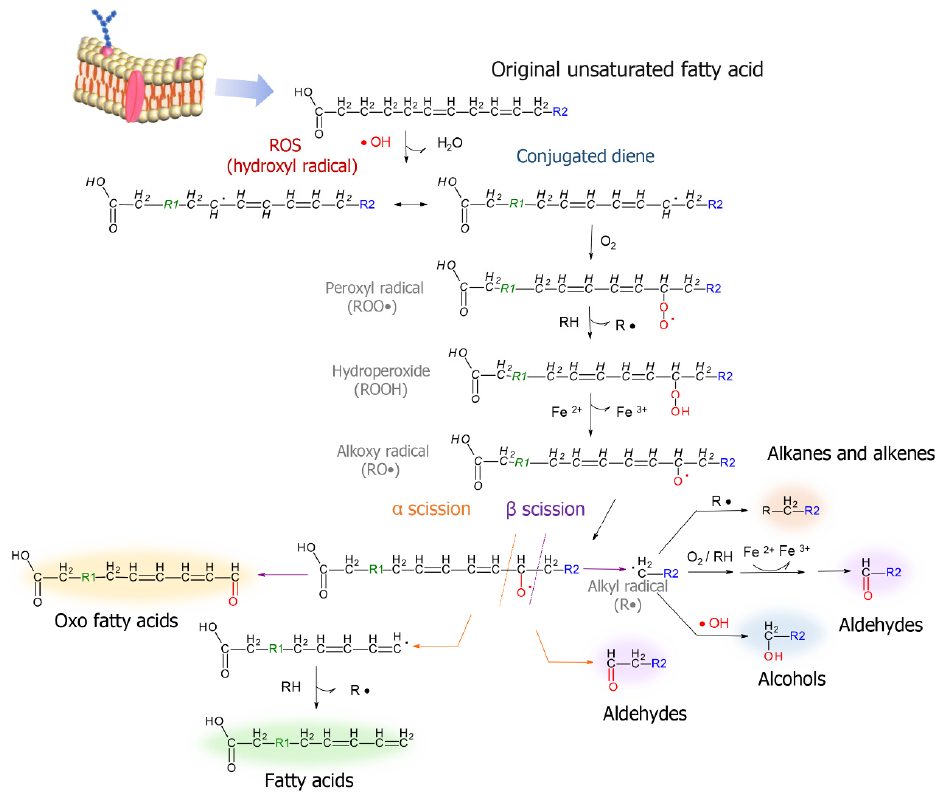
Figure 3. Lipid peroxidation mechanisms potentially involved in the formation of main classes of metabolic biomarkers. Based on Miekisch et al., 2004 [94] and Schaich et al., 2013 [95].